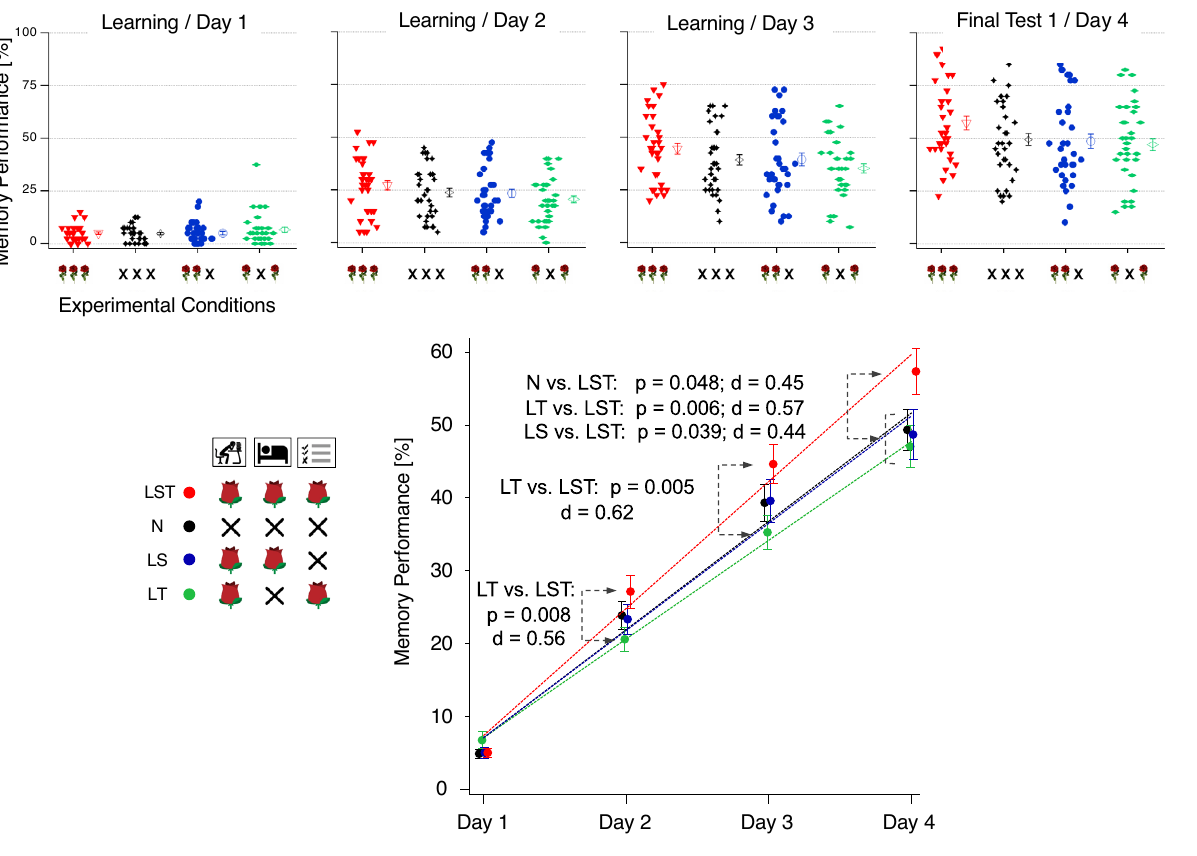
Figure 4. Results of the Intermediate Tests during the learning period. Top: Scatter plots of test results across four days. Filled icons represent data from individual participants, larger open icons are grand means within experimental groups (condition) ± SEMs. Bottom: Grand means per condition and day with linear fits and results from the post-hoc tests. Please notice that the presented fits are only for demonstration purposes. For the